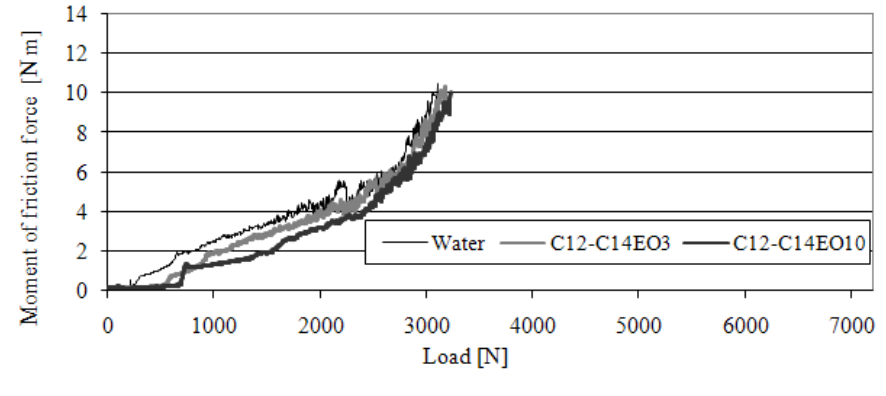
Figure 6. The course of changes in moment of friction force (M for water and 50% solutions of alcohols ethoxylated with 3 and 10 moles of ethylene